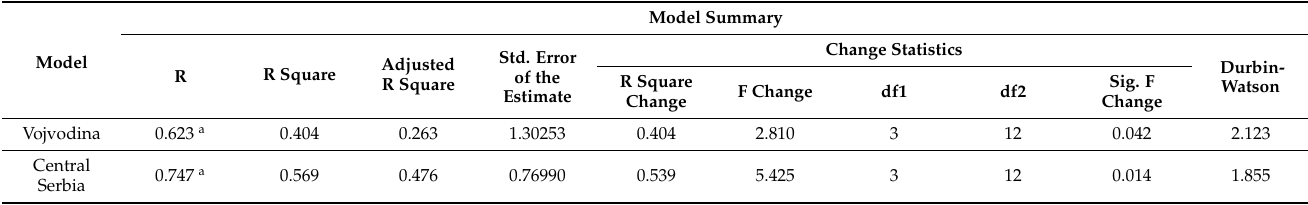
Table 3. Regression analysis for correlation of climate elements and maize yield in the Republic of Serbia for the period 2005–2020.